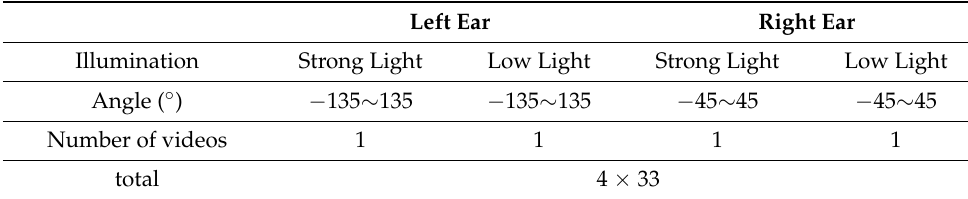
Figure 5. The rotation motion of the human ear. Table 6. Human ear database information of Eardata3.